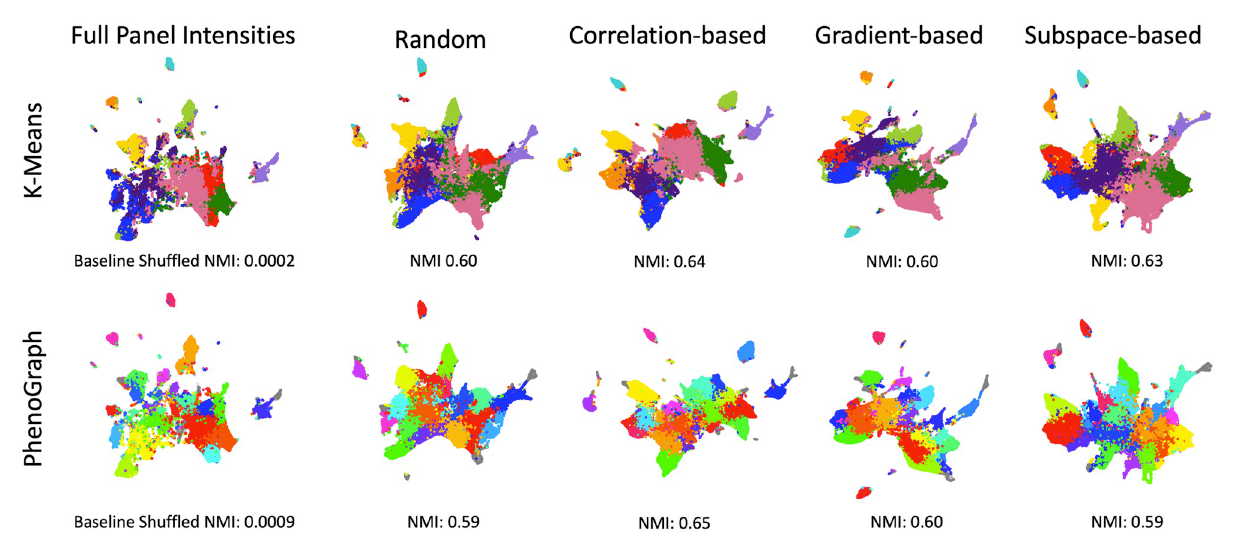
Fig 6. Clustering was performed on the full panel intensities to generate ground truth cell type clusters using k-means (k = 10, chosen with elbow method on silhouette score) and PhenoGraph 22 (with nearest neighbors set to 500 and minimum cluster size set to 2000). Random, correlation-based, gradient-based, and subspace-based selection methods were also clustered using reconstructed intensities as input to k-means and PhenoGraph using the same parameters. Clustering similarity to ground truth was performed using normalized mutual information (NMI). A baseline NMI for comparison was generated using randomly shuffled cluster labels. The clusters were projected into a UMAP 23 embedding and plotted to visually show the cluster results. For k-means clustering, cluster colors were matched for all selection methods by pairing each cluster’s cell compositions with the full panel. This was not done in PhenoGraph because each method had a different number of clusters, preventing 1-to-1 pairing. Outliers from PhenoGraph clustering are shown in